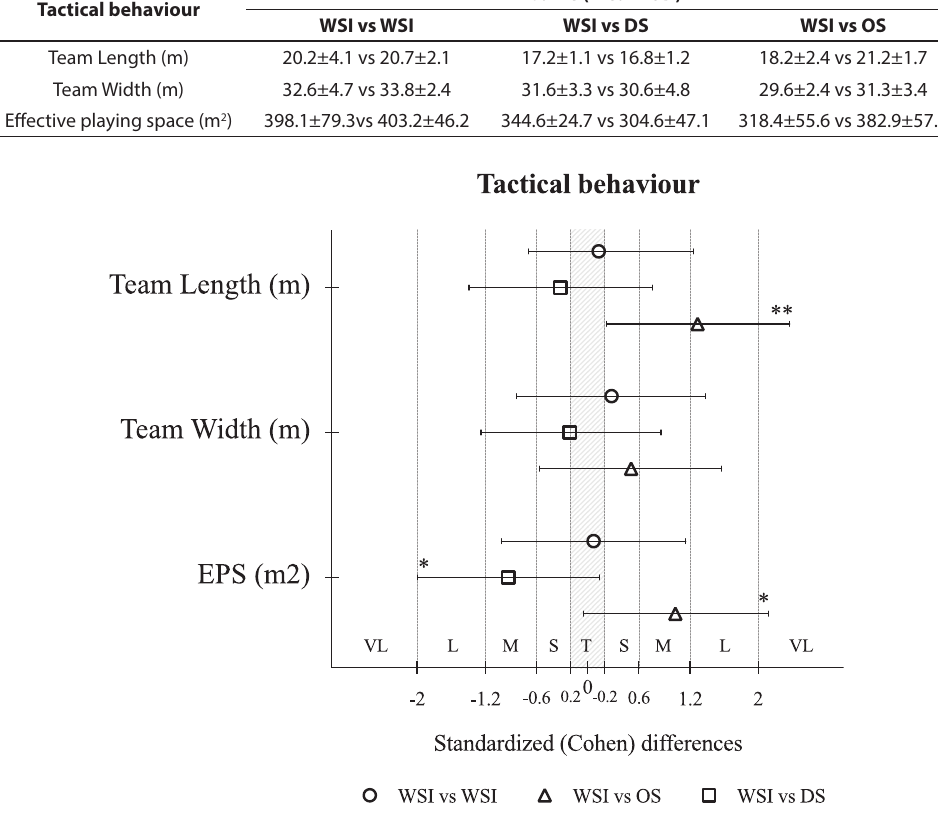
FIGURE 2 Standardized (Cohen) diff erences in tactical variables according to the game scenarios’ comparisons. Error bars indicate uncertainty in the true mean changes with 90% confi dence intervals. EPS = eff ective playing space. Asterisks indicate the likelihood for the magnitude of the true diff erences in mean as follows: *likely; **very likely